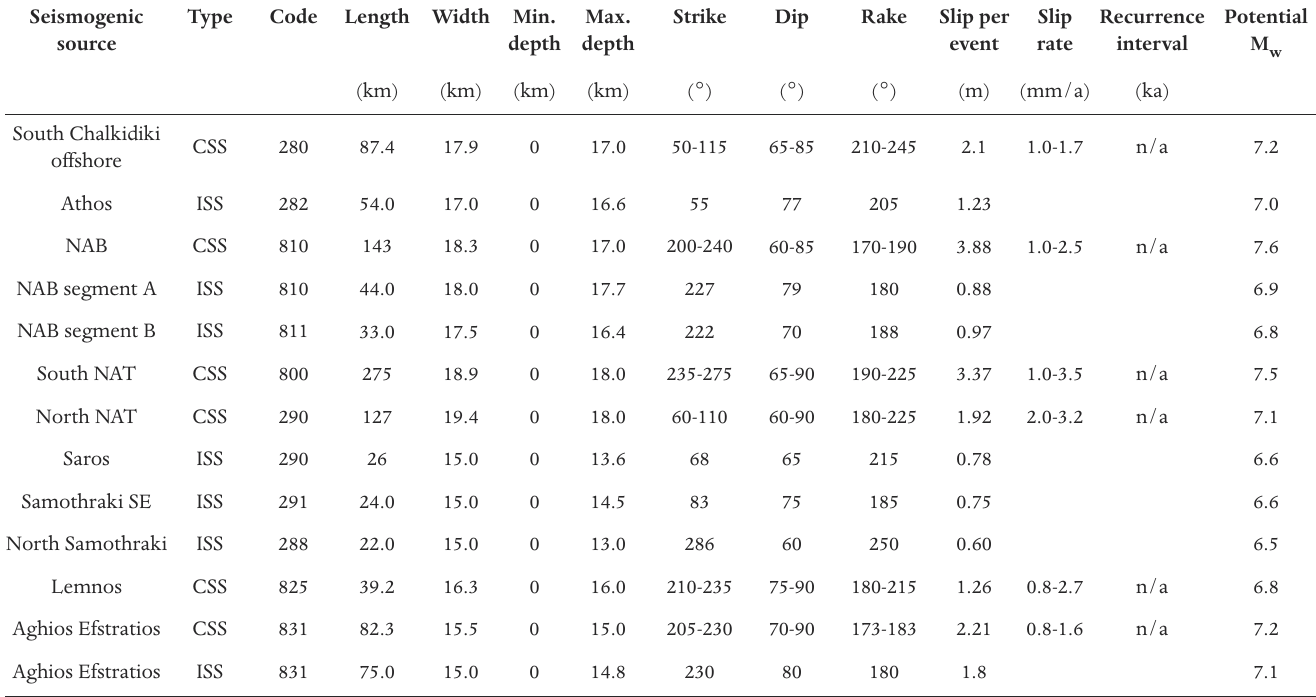
Table 5. Seismotectonic parameters of the CSSs and ISSs included in the North Aegean Sea fault system (see Figure 6). CSS, composite seismogenic source; ISS, individual seismogenic source; Code, identification number within the database; n/a, not available; NAB, North Aegean Basin; NAT, North Aegean